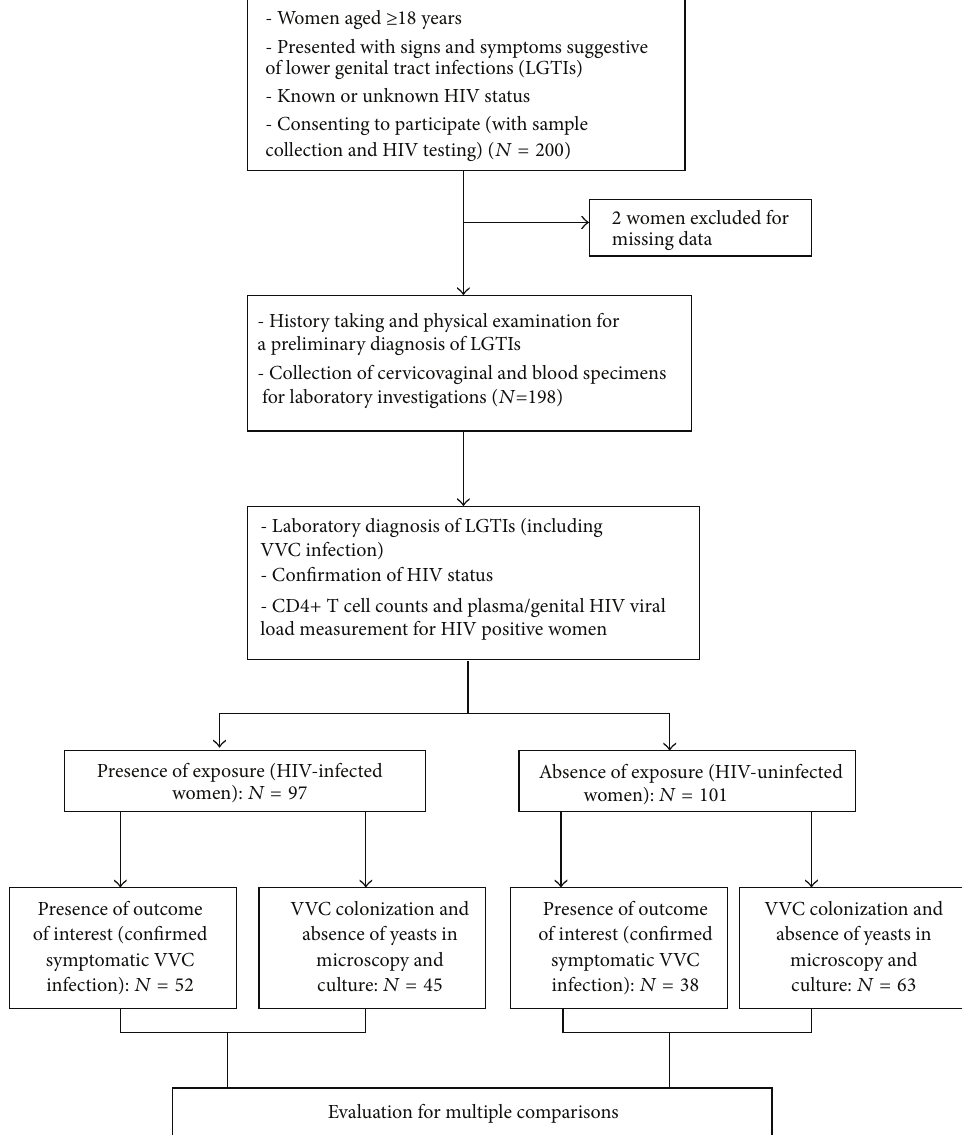
Figure 1: Selection criteria and characterization of the study population by HIV